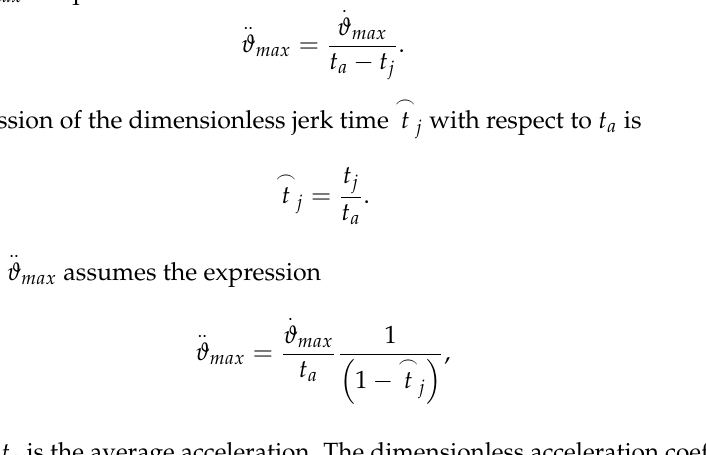
 t and different dimensionless STAPs. j t j